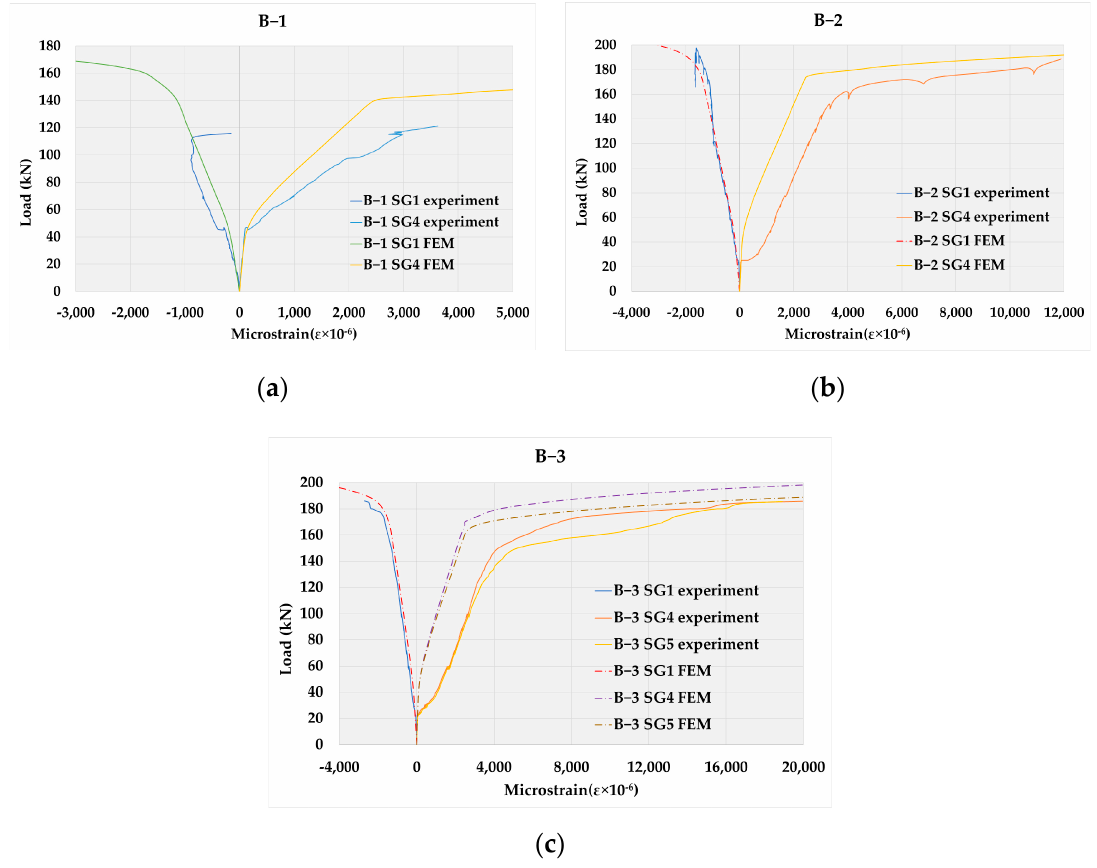
Figure 13 Load vs. microstrain curves in tensioned reinforcement in Section I for: ( a ) Beam B − 1; ( b ) Beam B − 2; ( c ) Beam B − 3.